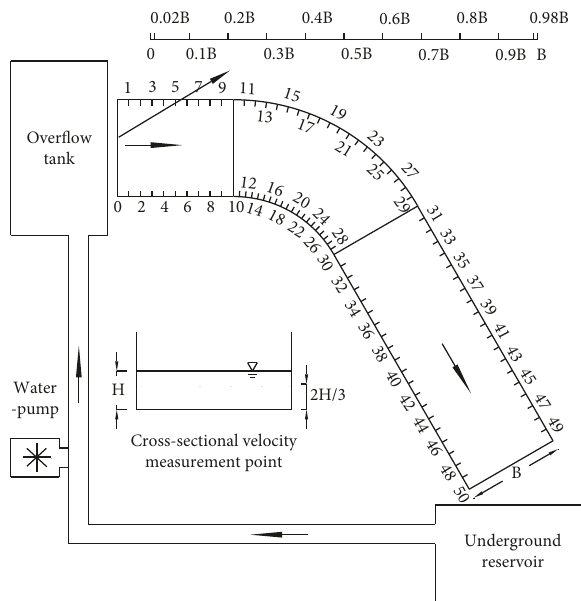
Figure 3: Test model structure and measuring points layout.